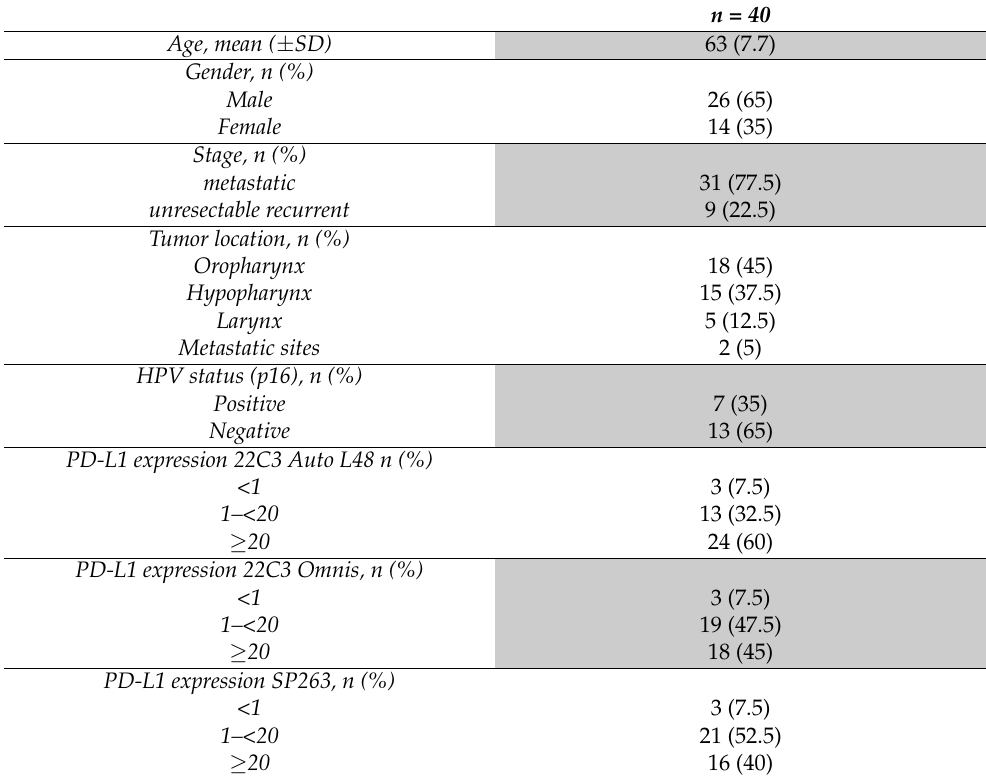
Table 1. Patient